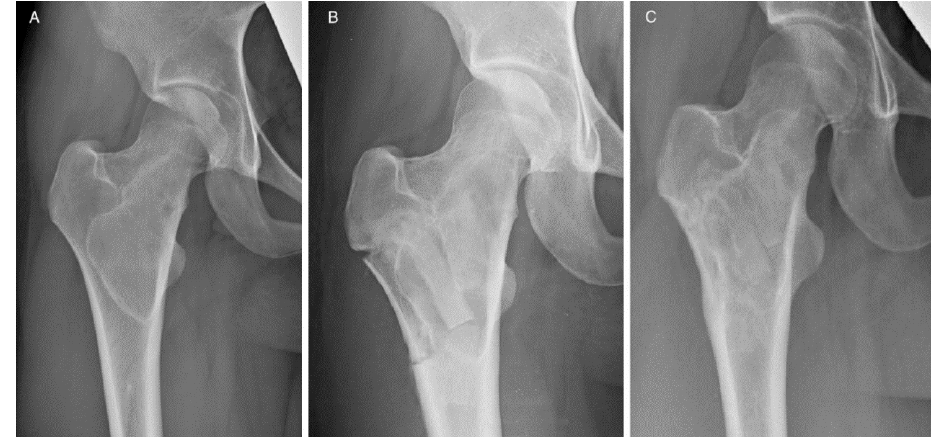
Figure 2. Patient 19. ( A ) Proximal right femur Fibrous Dysplasia. Radiological evolution after curettage and SB grafting with shaped blocks after ( B ) 3 and ( C ) 6 months of follow up.